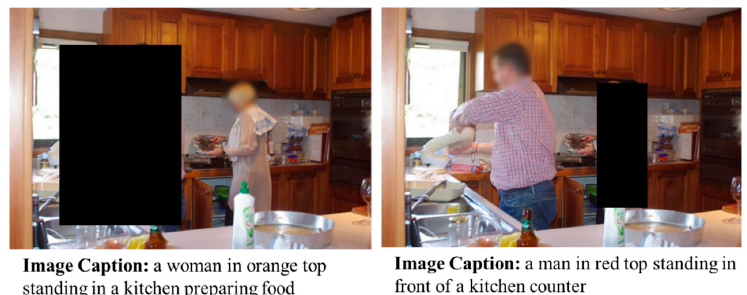
Figure 18. Extraction of the object outlined in a rectangle shape.